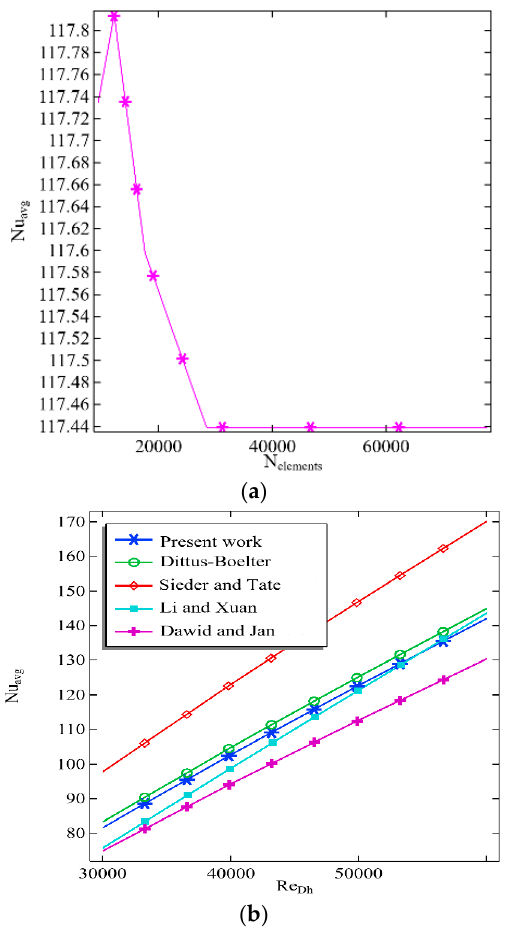
Figure 3. ( a ) Mesh independent study for average Nusselt number with an increasing number of elements. ( b ) Comparison of Nusselt number in the inner cylinder with available correlations.